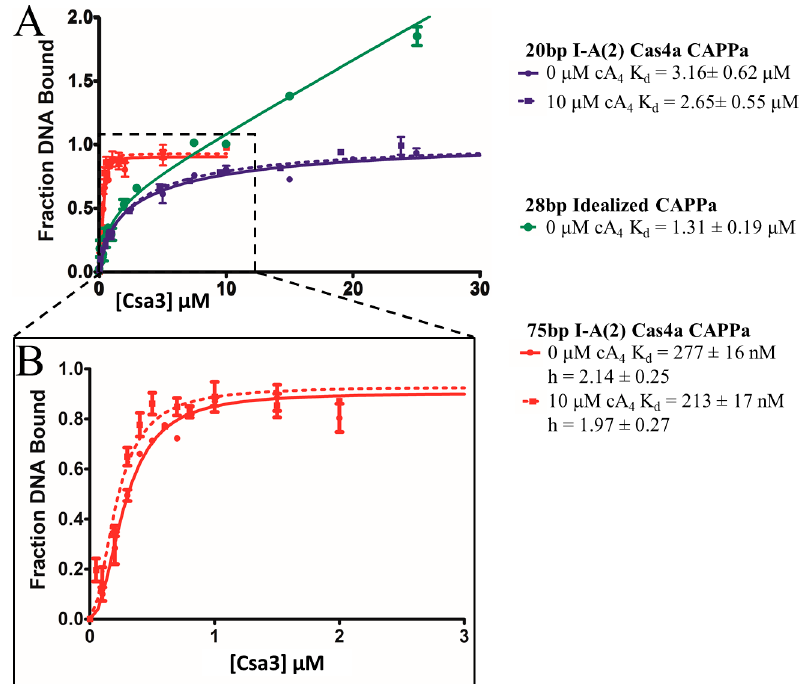
Figure 8. Csa3a binds CAPPa nonspecifically, in a cooperative and cA 4 -independent manner . ( A ) DNA binding was measured by fluorescence polarization at 50 °C. Both the 20 bp I-A (2) cas4a CAPPa (blue) and 28 bp idealized CAPPa (green) bound with low micromolar affinity, while the 75 bp I-A (2) cas4a CAPPa (red) was bound with 200–300 nM affinity. The addition of 10 μ M cA 4 (dotted lines) did not significantly change the affinity. Linear nonspecific binding after saturation was observed for the 28 bp idealized CAPPa. ( B ) Cooperative binding with a Hill coefficient of ~2 was observed for the 75 bp I-A (2) Cas4a CAPPa fragment. ssDNA oligonucleotides/primers used for generation of FP probes are listed in Table S4.